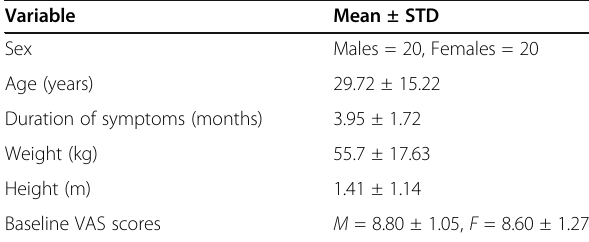
Table 1 The baseline characteristics of the